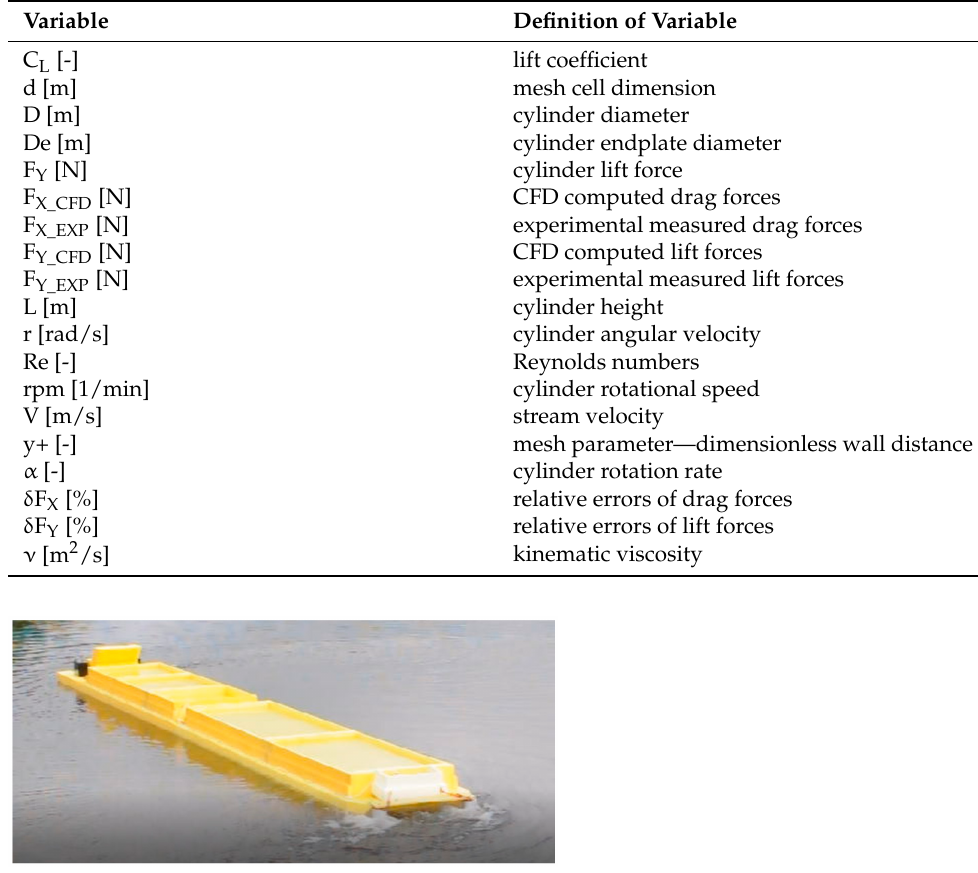
Figure 1. The push barge model in 1:20 geometrical scale during field